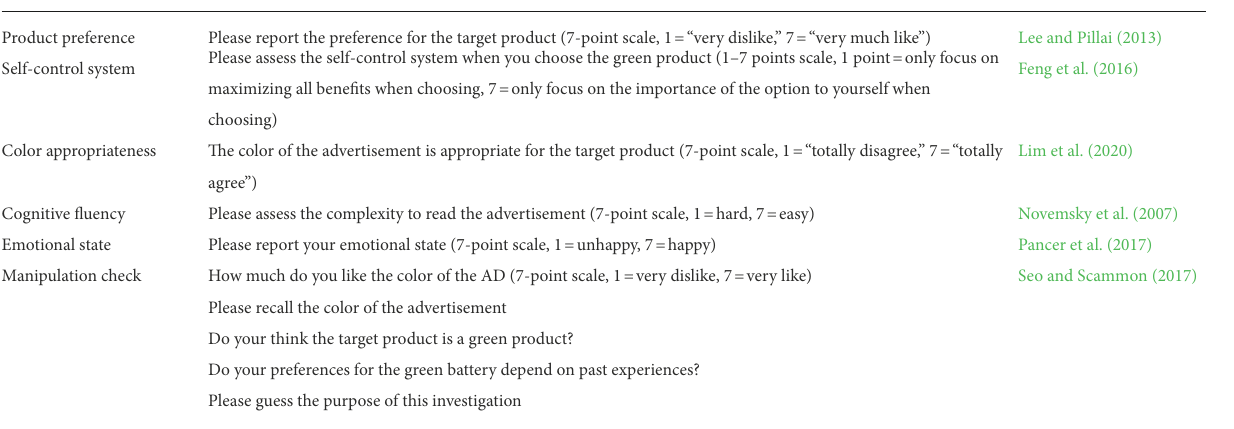
TABLE 1 Study 1: